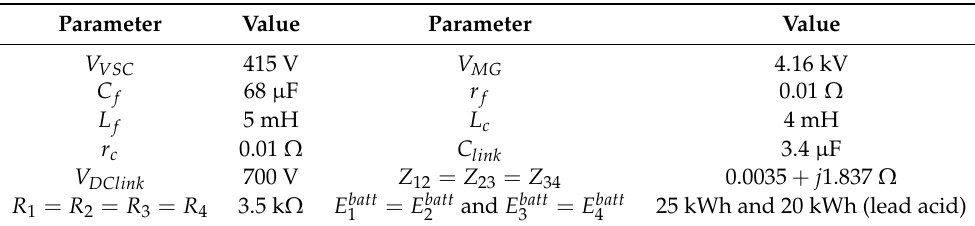
Table 2. Electrical Parameters.